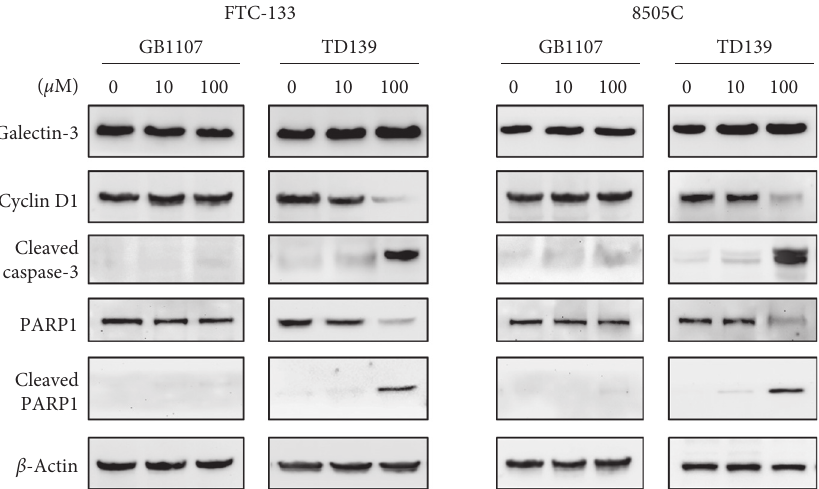
Figure 2: Expression of galectin-3, cyclin D1, and apoptosis-relevant proteins following treatment with galectin-3 inhibitors (GB1107 and TD139) in FTC-133 and 8505C thyroid cancer cells. The protein expression was determined using immunoblotting after 24-h